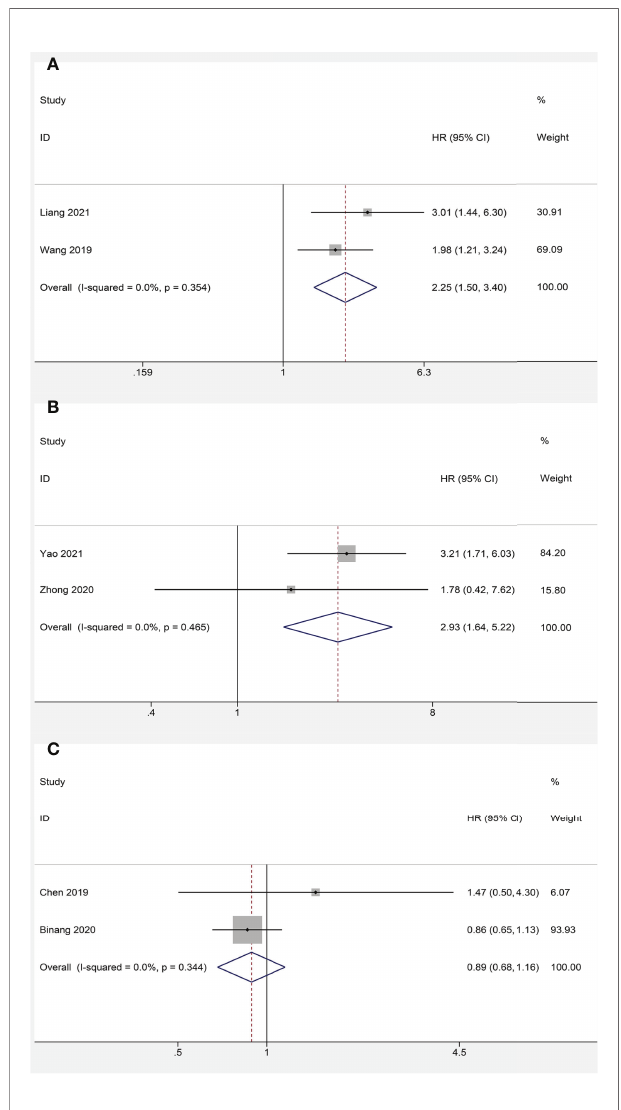
FIGURE 5 | Meta-analysis of the pooled HR of OS for hepatocellular carcinoma (A) nasopharyngeal carcinoma (B) and gastric cancer (C)